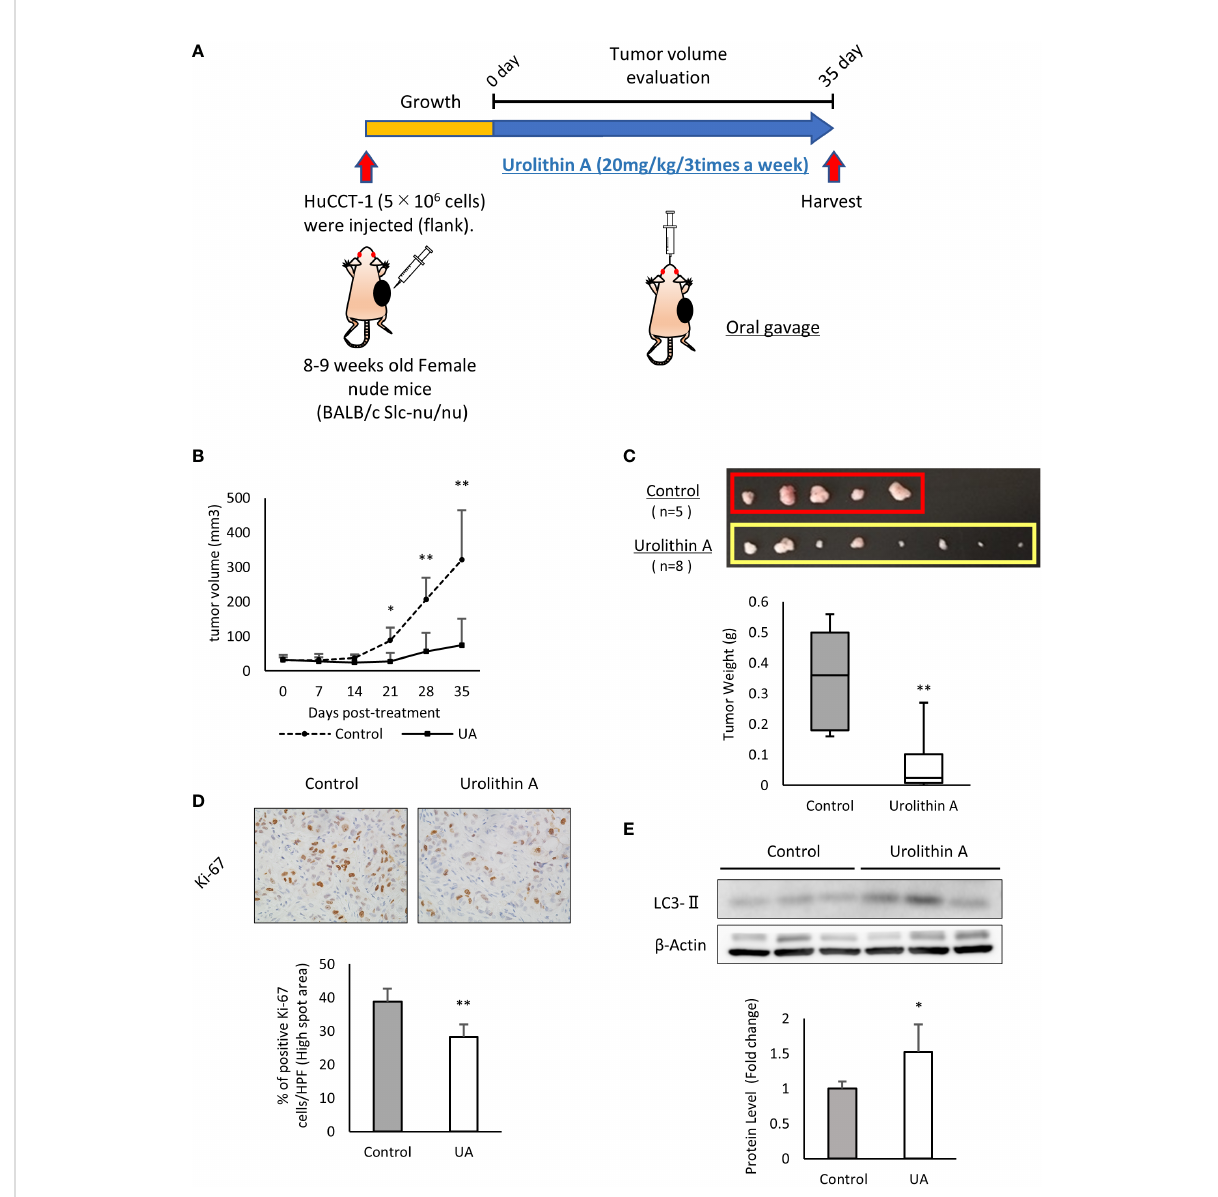
FIGURE 4 UA inhibits xenograft tumor growth in vivo . (A) Experimental design for UA treatment in the xenograft model. HuCCT-1 cells were injected into the fl ank of nude mice. UA (20 mg/kg, 3 times a week) or DMSO (control) were administered by oral gavage for 35 days. (B) The volume of subcutaneous tumors in the xenograft model was measured twice a week. Data represent the means of the control group (n = 5) or the UA group (n = 8). Bars, standard deviation; *P < 0.05; **P < 0.01. (C) Representative macroscopic images of tumors in nude mice obtained at day 35 after the start of the treatment. Data represent the means of the control group (n = 5) or the UA group (n = 8). Bars, standard deviation; **P < 0.01. (D) Representative Ki67-stained immunohistochemical images of the two groups. The positive rates of Ki67 staining were quanti fi ed by measuring fi ve high spot areas from each tumor. Data represent the means of the control group (n = 4) or the UA group (n = 4). Bars, standard deviation; **P < 0.01. (E) Autophagy was detected by Western blotting for LC3-II in the two groups. b -actin was used as an internal loading control. LC3-II levels were normalized against b -Actin and represented the means of three independent experiments. Bars, standard deviation; *P <